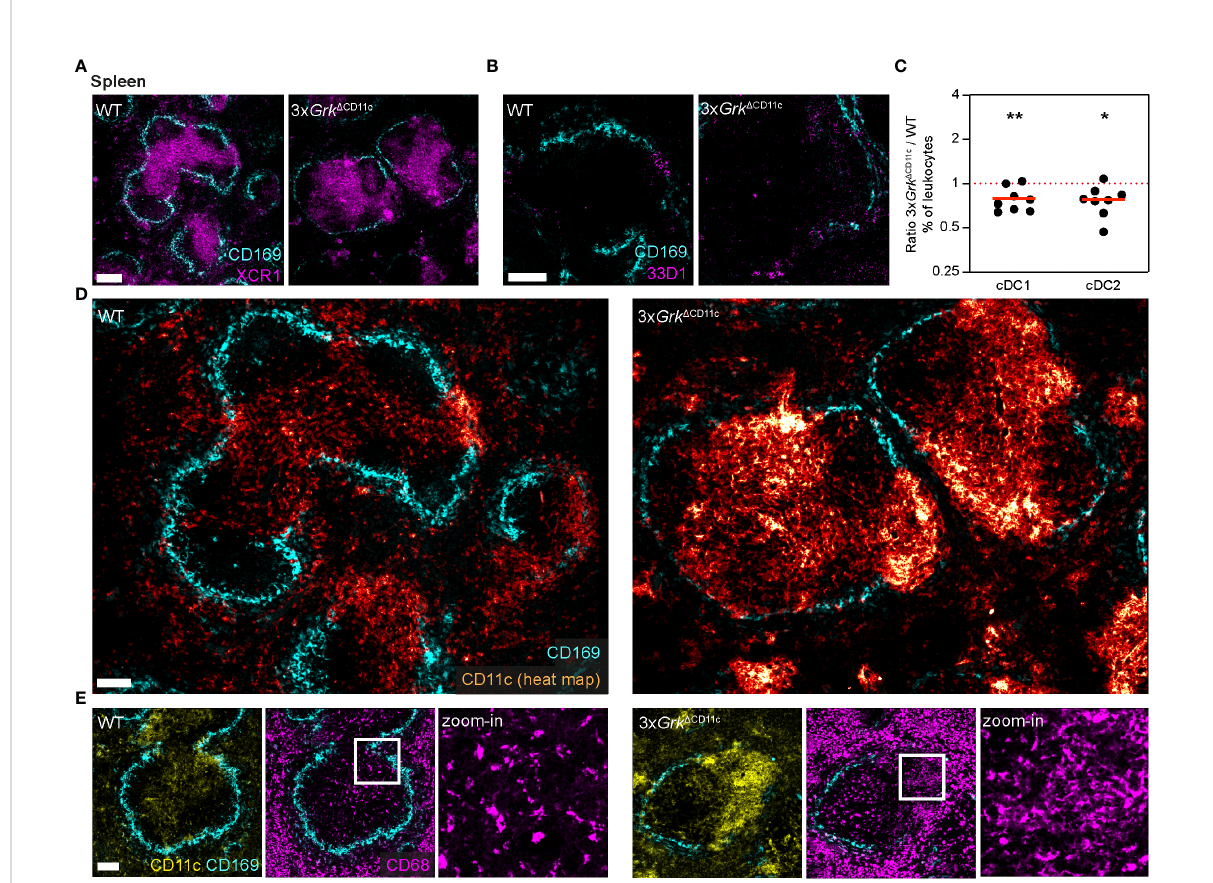
FIGURE 6 Complete GRK depletion impairs DC differentiation in the spleen. (A, B) Positioning of DC subsets in the spleens of 3x Grk D CD11c and littermate control mice. cDC1 were detected with immunostaining against XCR1 (A, magenta) and cDC2 with anti-33D1 (B, magenta). Marginal zone macrophages (CD169, cyan) are displayed for orientation. Scale bars: 200 µm (A) , 100 µm (B) . (C) Quanti fi cation of splenic DC subsets compared to all leukocytes by fl ow cytometry. Displayed are ratios of 3x Grk D CD11c versus WT. n = 8 mice per genotype. Bars display the mean. ** P < 0.01, * P < 0.05, one sample t test. (D) Representative images of CD11c-expressing cells (glow heat map displays signal intensity) in spleens of 3x Grk D CD11c and littermate control mice. Marginal zone macrophages (CD169, cyan) are displayed for orientation. Scale bar: 100 µm. (E) Expression of the macrophage marker CD68 (magenta) in spleens of 3x Grk D CD11c (right) and littermate control mice (left). Zoom-in shows CD68 staining in spleen areas of high CD11c (yellow) signal. Marginal zone macrophages (CD169, cyan) are displayed for orientation. Scale bar: 100 µm (left, middle), 30 µm